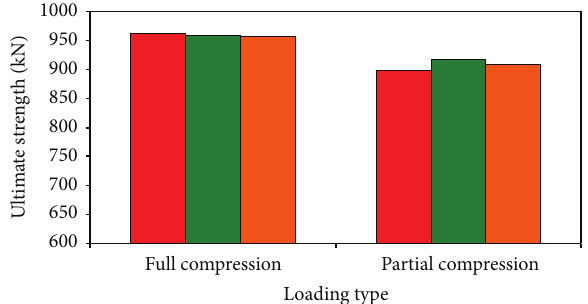
Figure 9: Ductility behavior of circular CFST column subjected to full and partial compression—comparison.